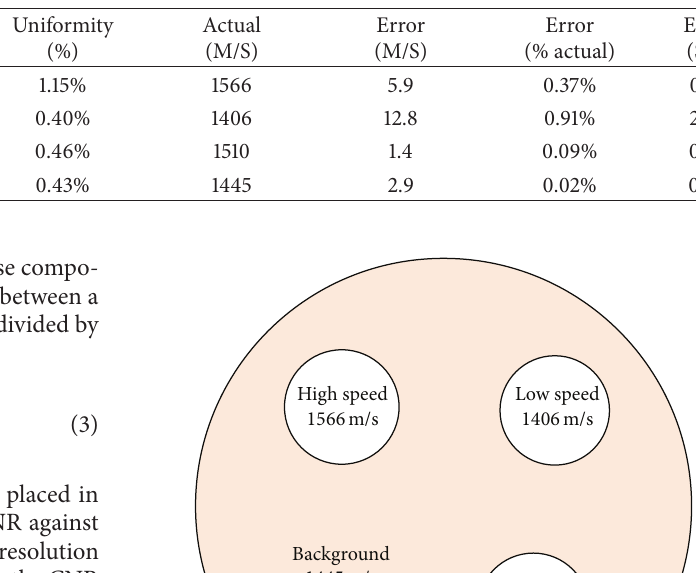
Table 1: Speed-of-sound accuracy against the speed phantom measured with twin pistons.